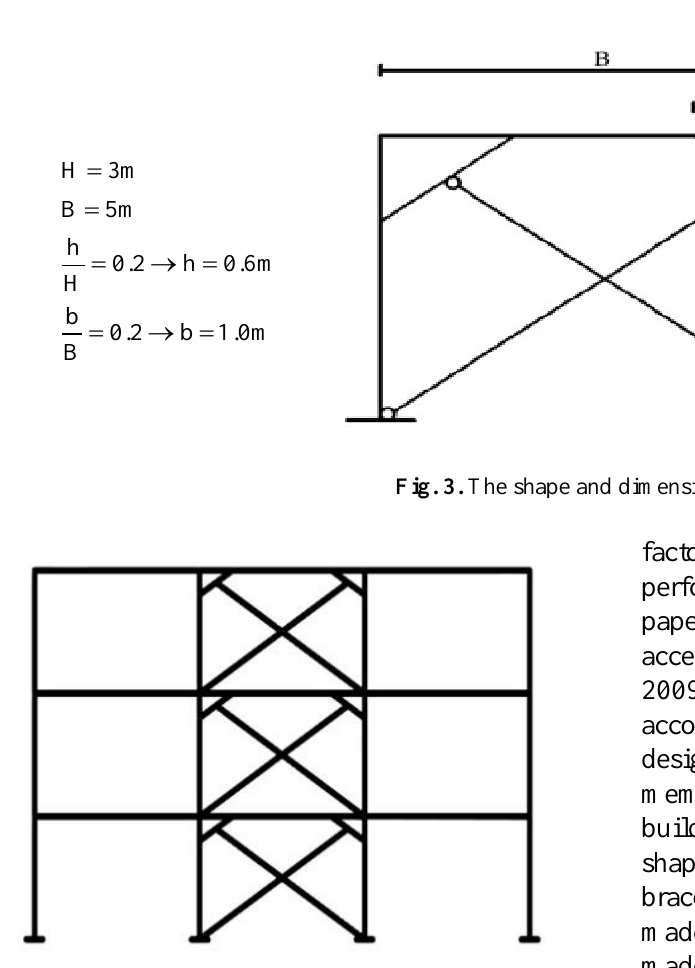
Fig. 4. Geometry of the 3-story frame.